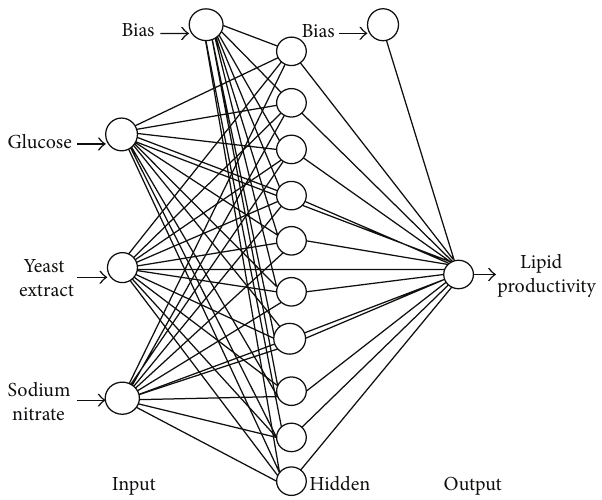
Figure 2: Parity plots correlating the observed and predicted values of the ANN models with respect to different testing dataset.